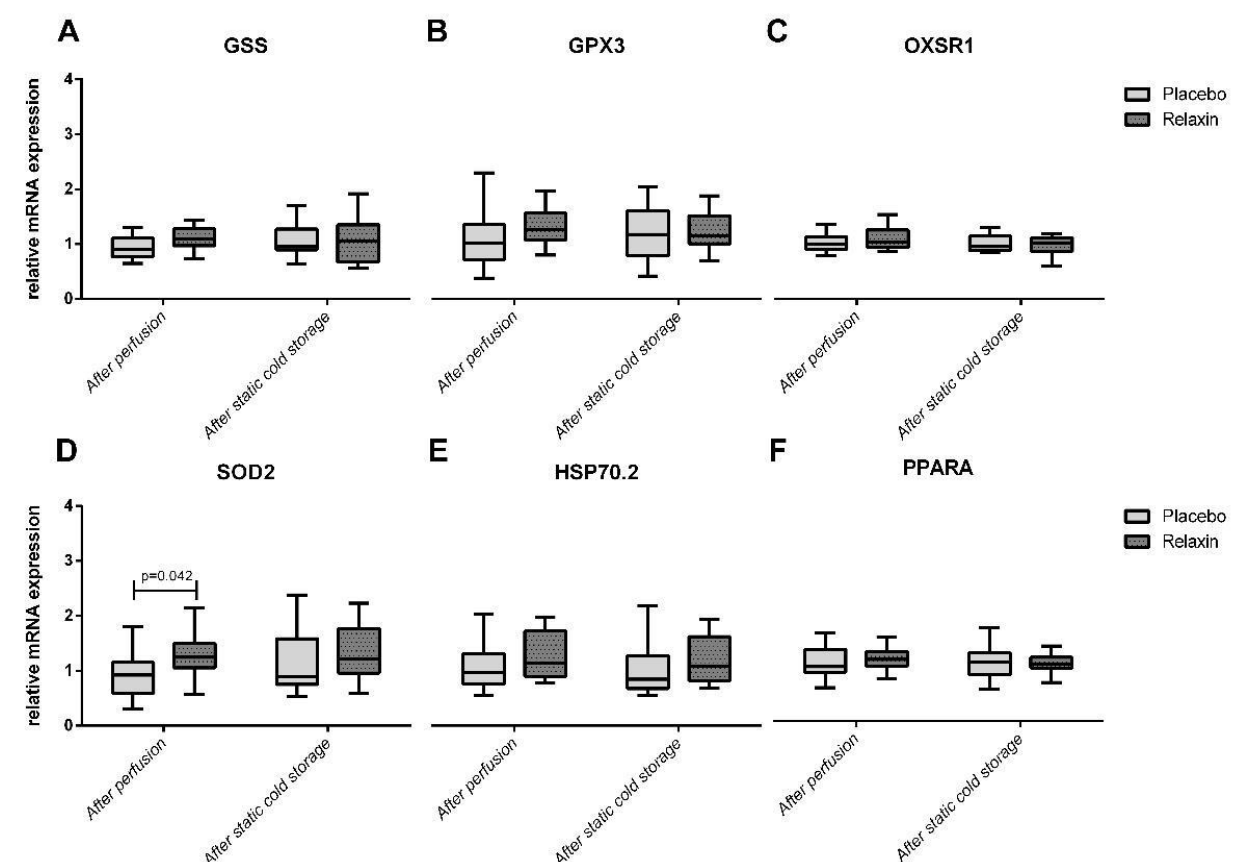
Figure 2. Oxidative stress-related genes expression in kidney tissue after perfusion and static cold storage in Relaxin and Placebo groups. GSS: Glutathione Synthetase; GPX3: Glutathione Peroxidase 3; OXSR1: Oxidative Stress Responsive Kinase 1; SOD2: Superoxide Dismutase 2; HSP70.2: Heat Shock Protein 70.2; PPARA: Peroxisome Proliferators Activated Receptor Alpha.